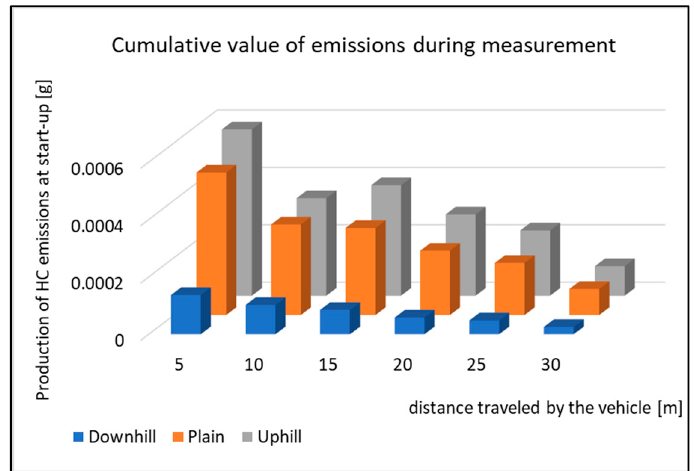
Figure 16. Cumulative value of HC emissions during measurement.